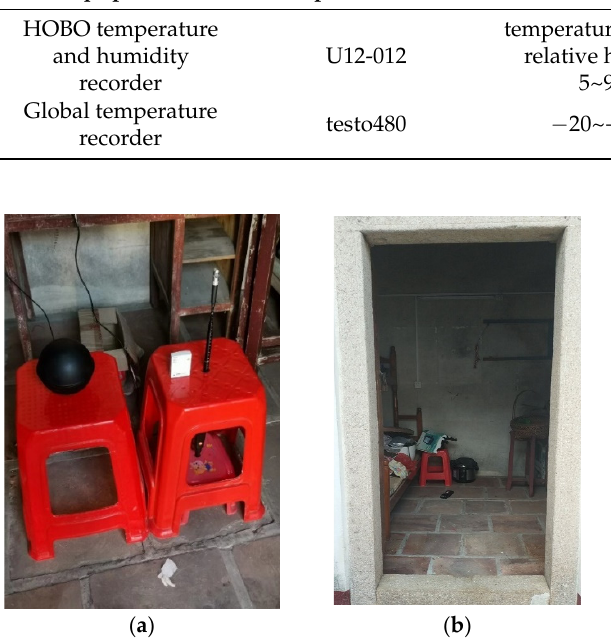
Table 1. The parameters of the measurement equipment used.